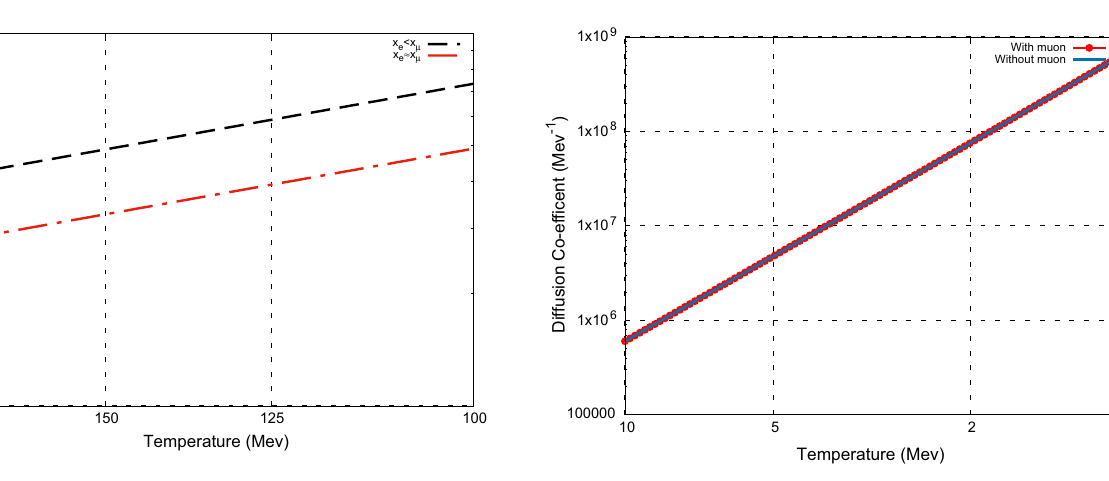
size of the inhomogeneity is very small compared to the size of the universe at that temperature, we can ignore the effect of the expanding universe on the decaying